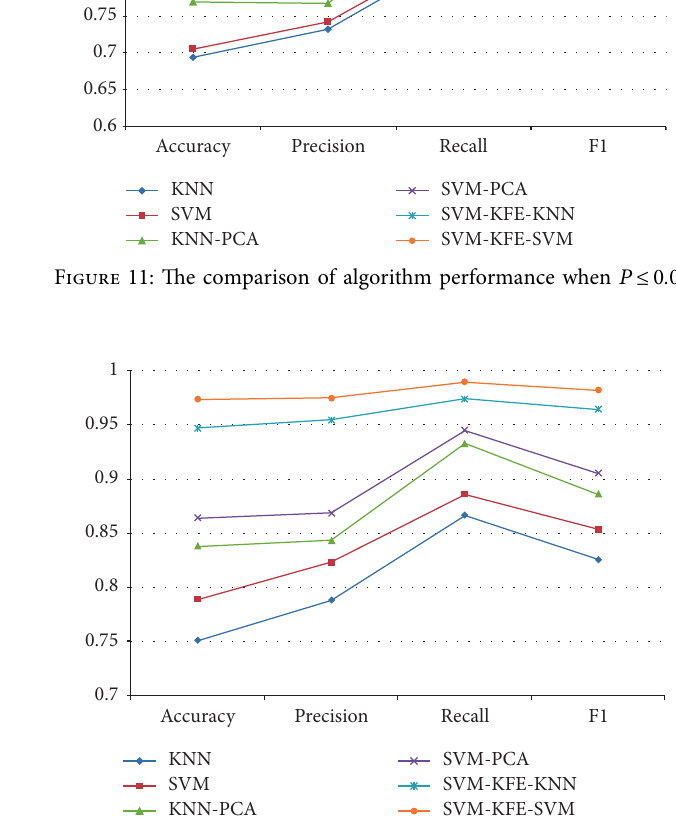
Figure 12: The comparison of algorithm performance when P ≤ 0 . 01.